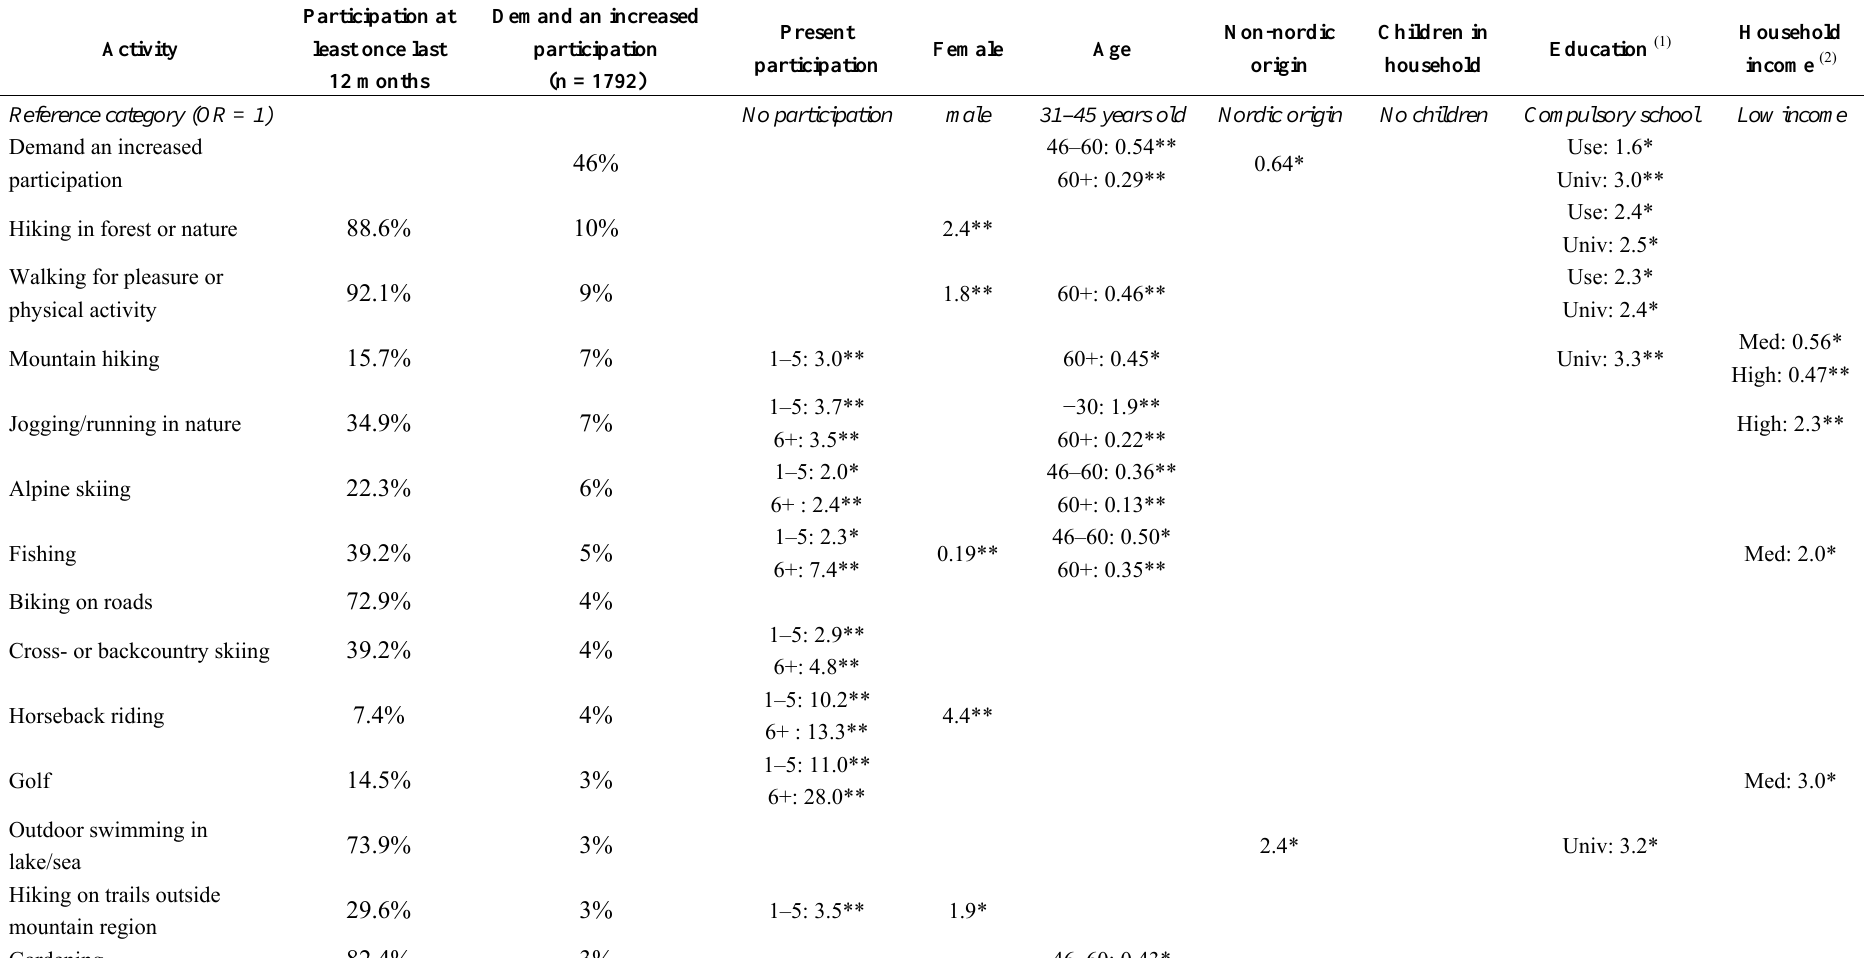
Table 1. Logistic regression analyses of the demand to increase participation in outdoor recreation activities. Significant (p < 0.05) odds ratios (OR) are shown in the